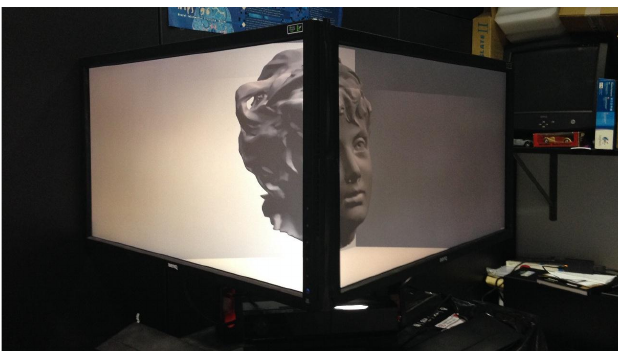
Fig. 4. Snapshot of the proposed “virtual holographic” case, on which the stereoscopic projections of a virtual artwork are displayed from the point of view of an user located in a position similar to E 2 of Fig. 1.